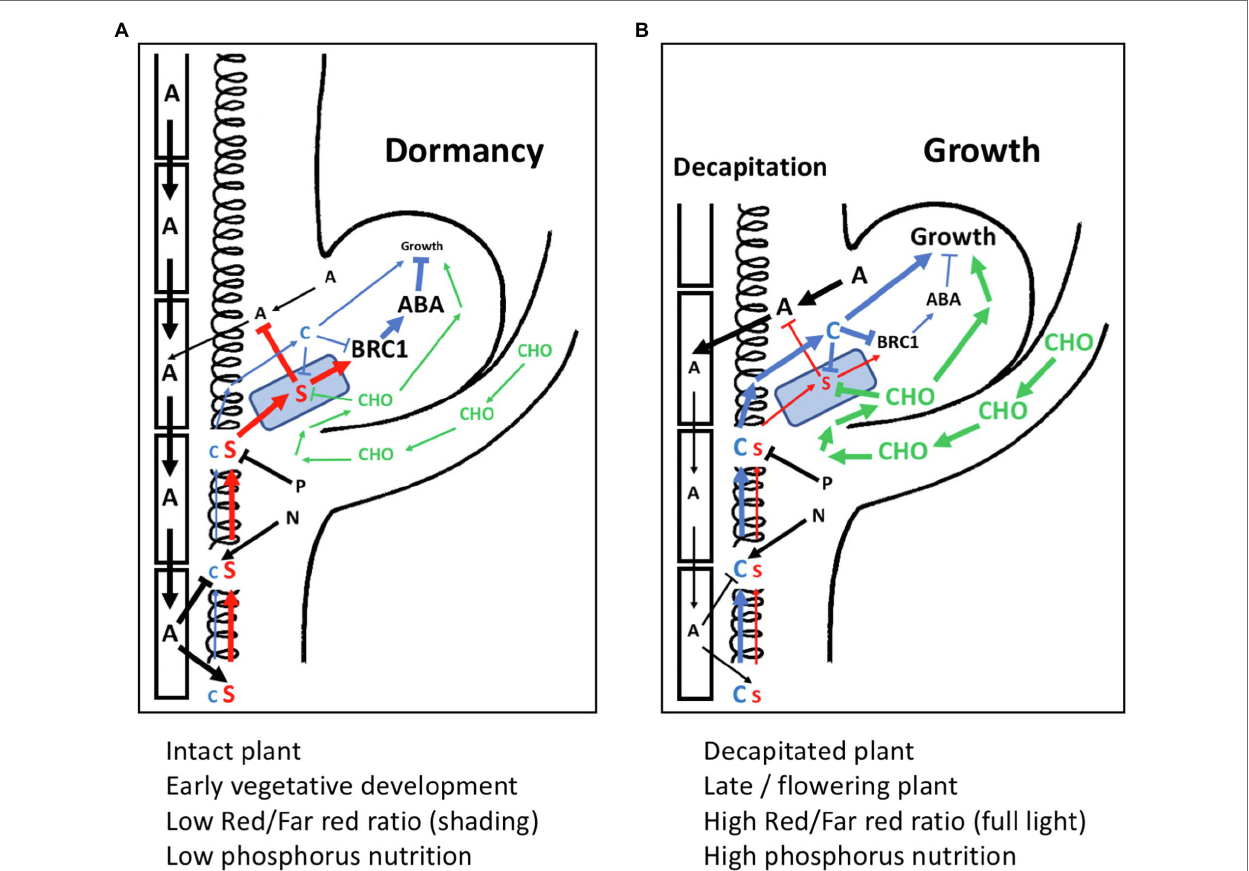
FIGURE 6 | Model for the interactions of SL with other components in apical dominance. (A) An axillary bud under the influence of apical dominance with active polar auxin transport stream in the stem, which inhibits cytokinin (C) biosynthesis, and stimulates strigolactone (S) production. Strigolactone enters the buds via PDR1 transport (represented by a blue PDR1-expressing square). Strigolactone inhibits auxin canalization from the bud, and stimulates BRC1 gene expression. BRC1 activates the ABA dormancy program, resulting in growth arrest. The stimulatory effect of nitrogen (N) on cytokinin biosynthesis and the inhibition of strigolactone biosynthetic genes by phosphorus (P) are indicated, although they are at a steady-state intermediate level and do not influence bud activity. Relative signaling strength is represented by font size and thickness of the arrows. (B) Situation as in (A) depicting changes upon decapitation of the main shoot apex. Sugars (CHO) rapidly enter the bud, where they interfere with strigolactone sensing, and rapidly stimulate growth. Polar auxin transport in the stem is weak, reducing strigolactone biosynthesis and releasing the inhibition of cytokinin biosynthesis in the stem. Lower strigolactone levels allow canalization of auxin from the bud, while increased cytokinin levels further stimulate bud outgrowth by reducing BRC expression. Relative signaling strength is represented by font size and thickness of the